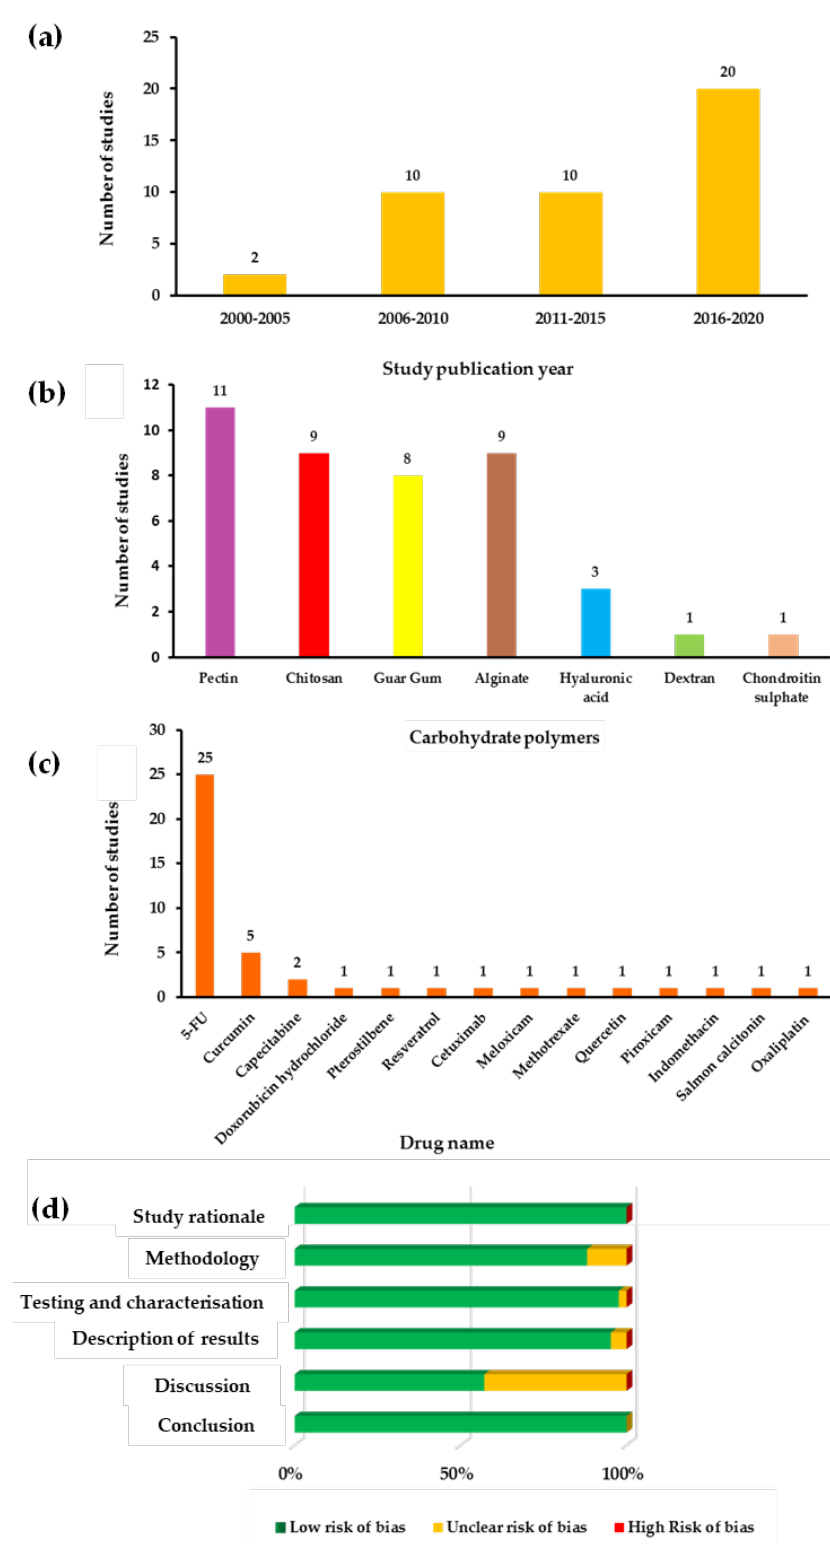
Figure 3. ( a ) Bar chart indicating the number of articles from Jan 2000 to Jun 2020 ( b ) Application of natural polysaccharides for colon-specific drug delivery ( c ) Distribution of drugs for targeted delivery in colorectal cancer and ( d ) Overall risk of bias assessment according to the six areas covered among the included studies.